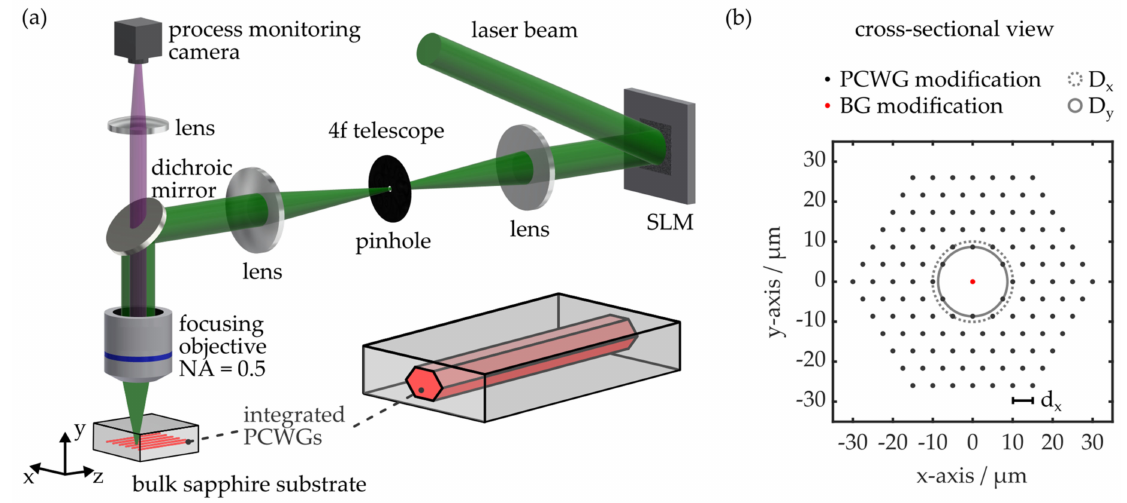
Figure 2. ( a ) Schematic of the employed femtosecond laser setup. ( b ) Exemplary cross-sectional schematic of a sapphire photonic crystal waveguide (S-PCWG) with integrated Bragg grating (BG). d x indicates the distance of two modification lines in x-direction, while D x and D y represent the theoretical inner hexagon diameters in x- and y-direction,